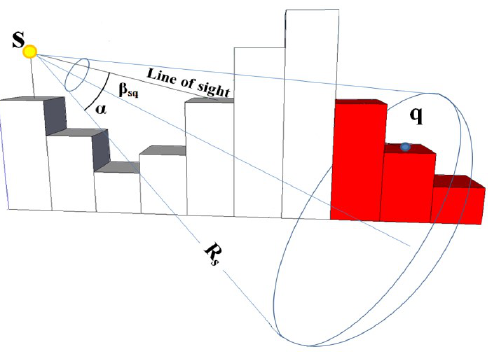
Figure 3. Estimation of three-dimensional coverage in raster model (red pixels are not covered by the sensor